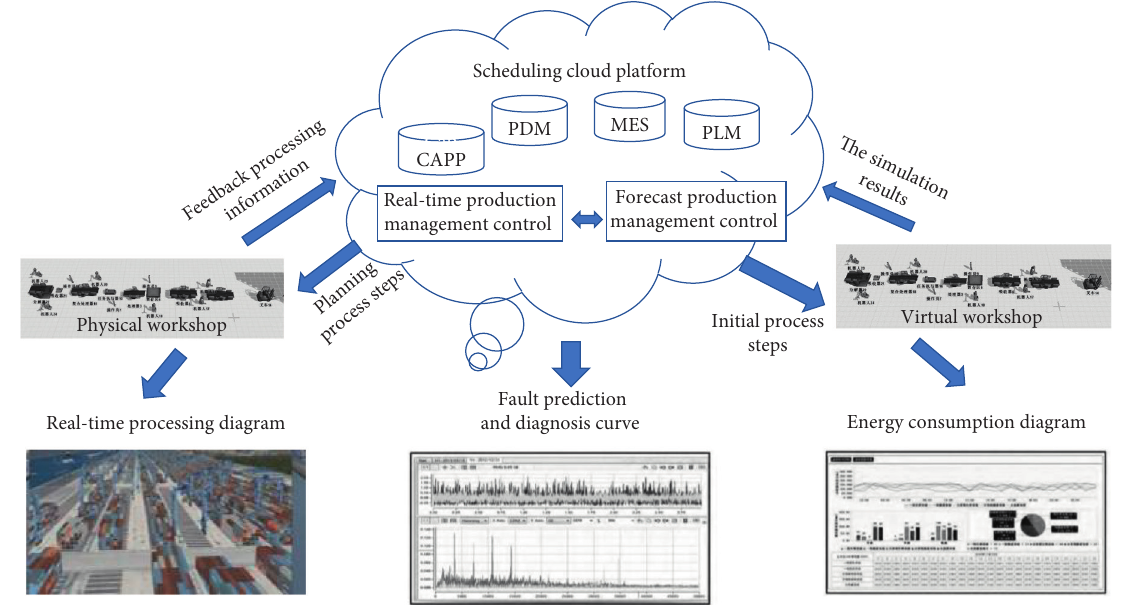
Figure 2: Fusion of digital twinning and shop